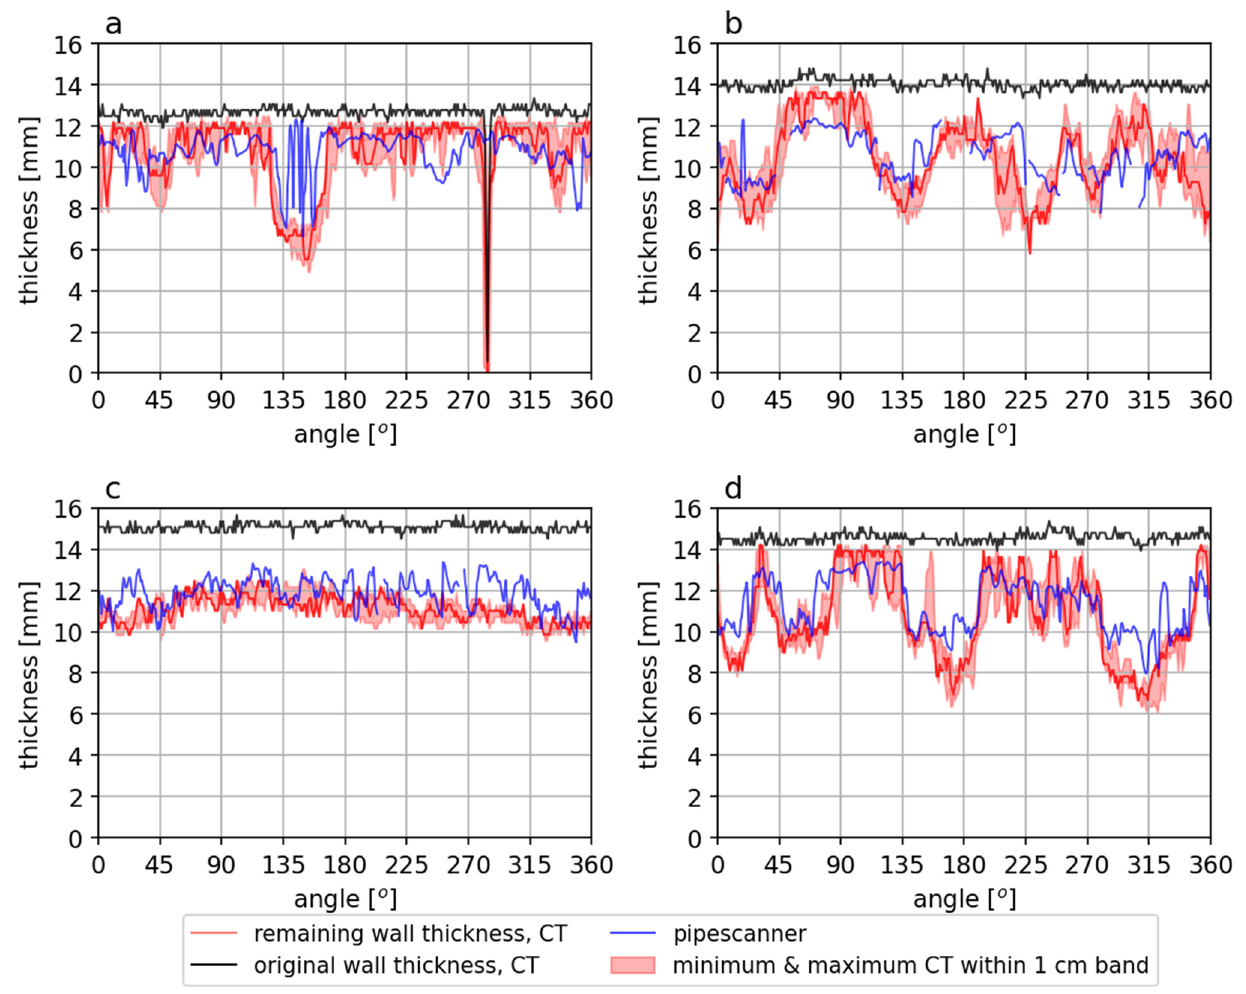
Figure 4. Comparison of CT (red) and ultrasound (blue) measurements of the remaining wall thicknesses of the four cross- sections of degraded pipes shown in Figure 2 (the lettering ( a – d ) corresponds to pipes with the same letters in Figure 2). The black lines represent the original wall thickness (comprising degraded and undegraded material) as determined from the CT scans.